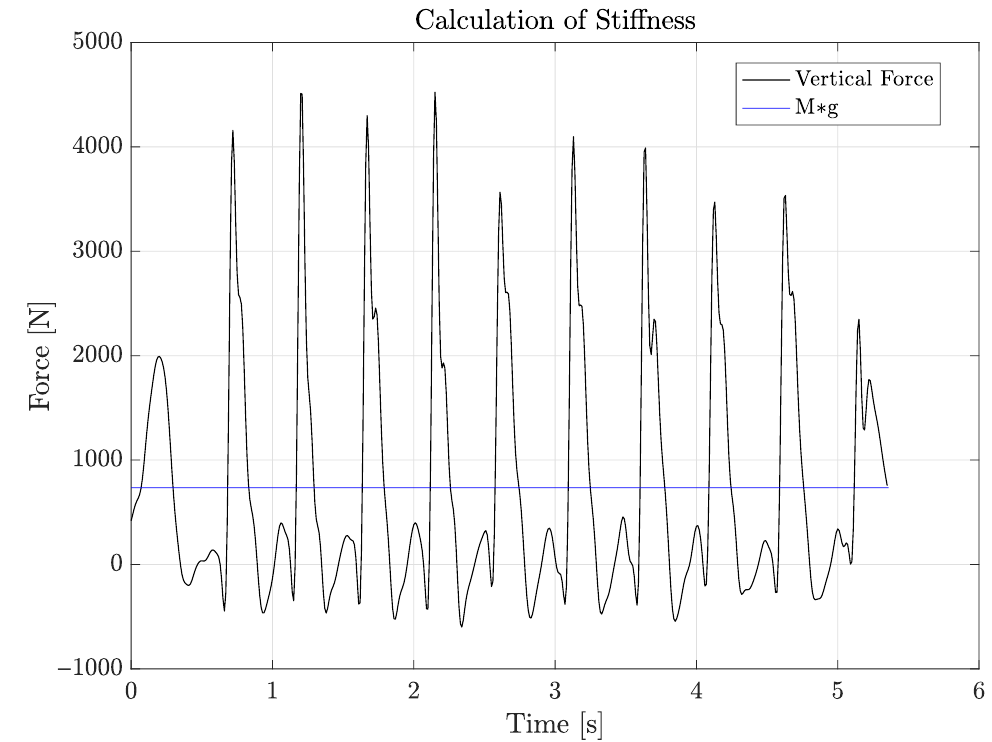
Figure 12. Stiffness calculation